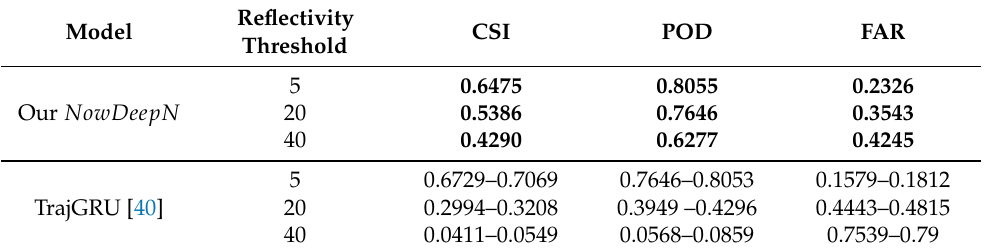
Table 5. Comparison to the work of Tran and Song